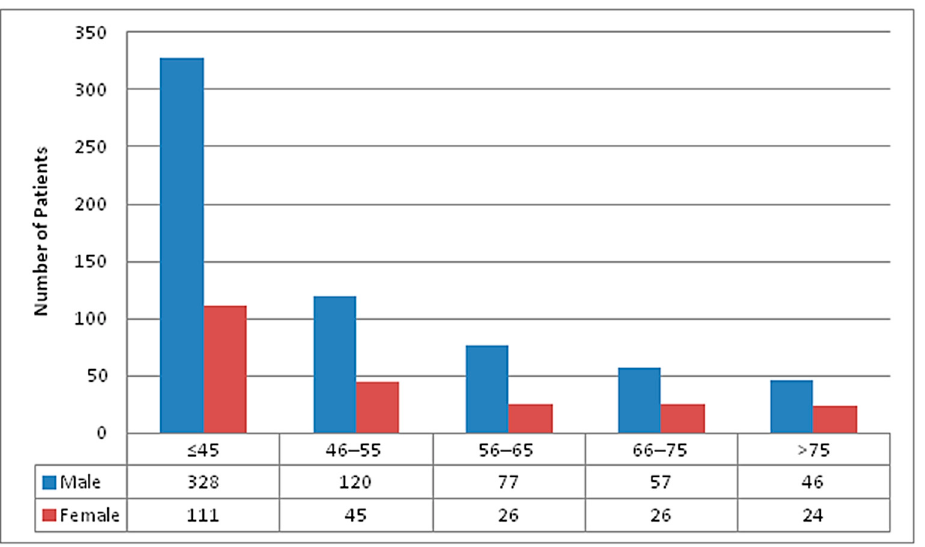
Figure 1. Age and Gender wise distribution of total COVID-19 patients admitted in STIDH (N = 860).